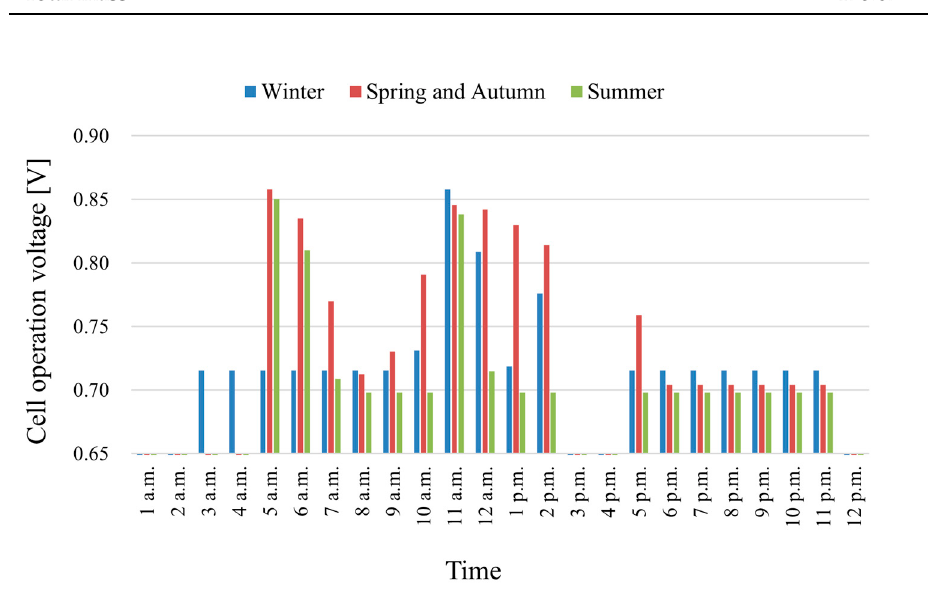
Figure 5. Operating single-cell voltage for the demand (initial).